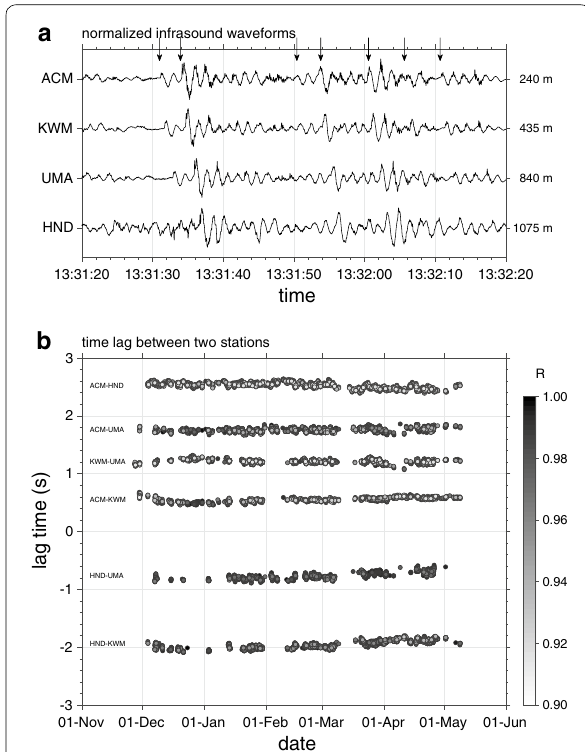
Fig. 5 Well-correlated infrasound waveforms between the stations. a Normalized one-minute infrasound waveforms recorded at four stations on December 15, 2015. Each trace from top to bottom is aligned in order of its horizontal distance from the crater center (annotated at the right; see Fig. 1). Arrows indicate beginning of monochromatic oscillations. b Results of cross-correlation analyses between all stations’ data filtered by a 0.2–1.0 Hz pass-band. Only data with cross-correlation coefficients of R ≥ 0.9 are